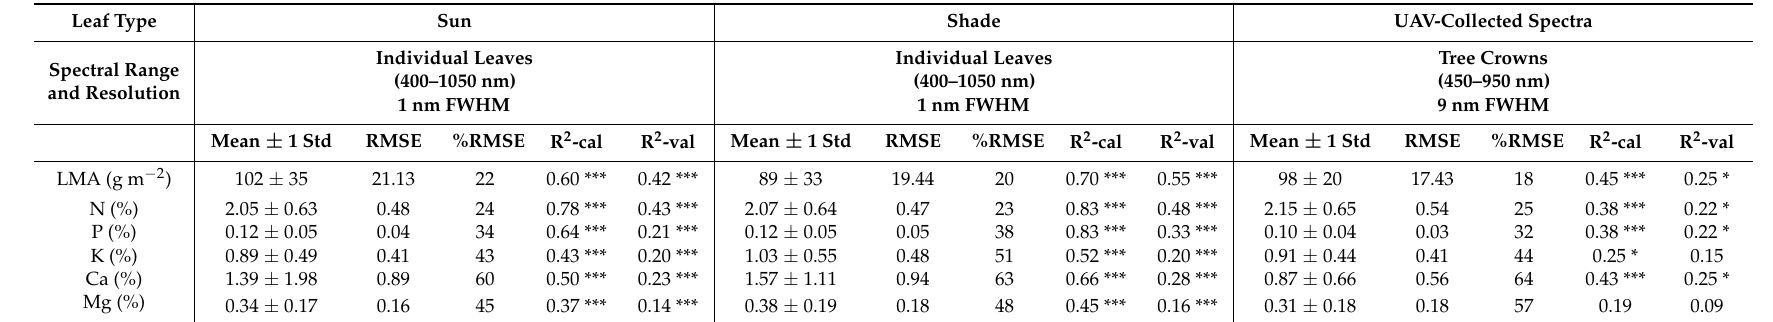
Table 2. PLSR results for (i, ii) individual sun and shade leaf spectra. n = 753 for sun and shade leaves respectively. (iii) UAV-collected tree crown spectra. n = 58 for UAV-collected tree crown spectra. RMSE = Root mean square error. r 2 -cal represents the 70% of data used to create the empirical model and r 2 -val the 30% of data upon which the model was tested. The level of significance ( p ) is indicated (* p < 0.10; ** p < 0.05; *** p < 0.01). Results are the average of 30 model runs. All field-collected data is reported on a dry mass